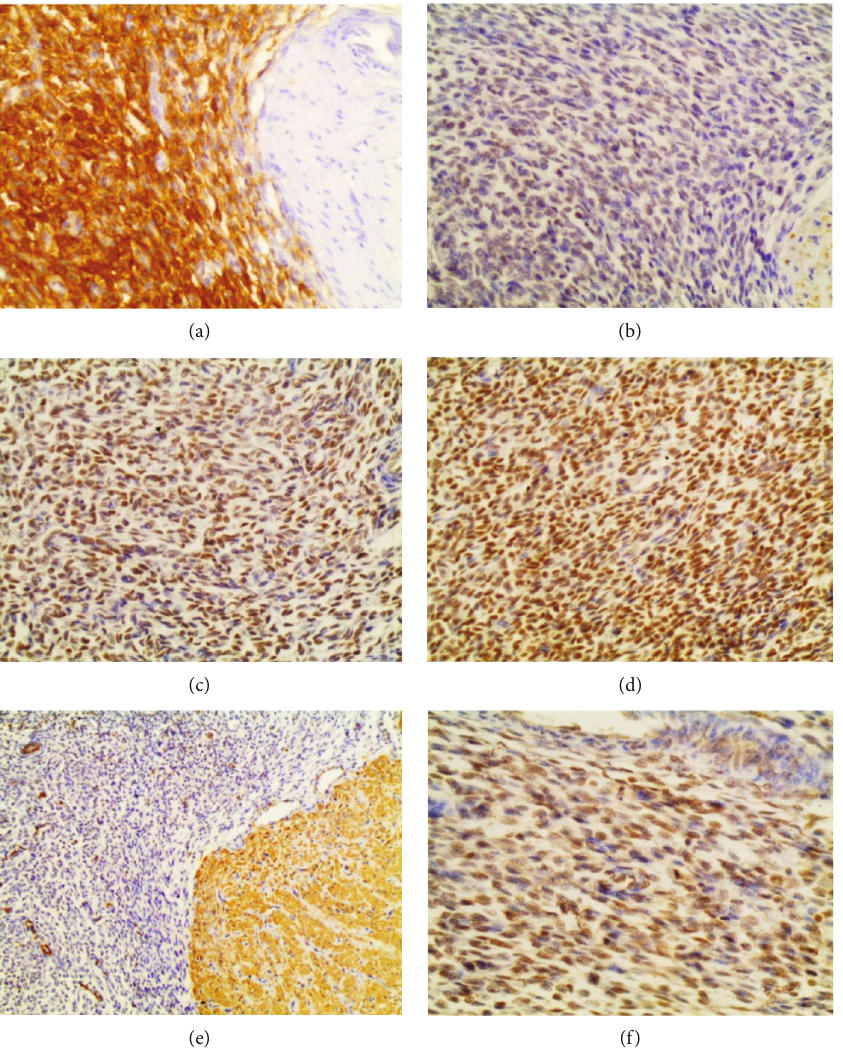
Figure 3: Immunohistochemistry stains showing the endometrial stromal cells: (a) di ff use and strong positivity for CD10; (b) Desmin: negative; (c) ER: positive (total score + 4/8 ); (d) PR: positive (total score + 6/8 ); (e) SMA: negative (internal control); (f) ki67: low rate ~ 10%.